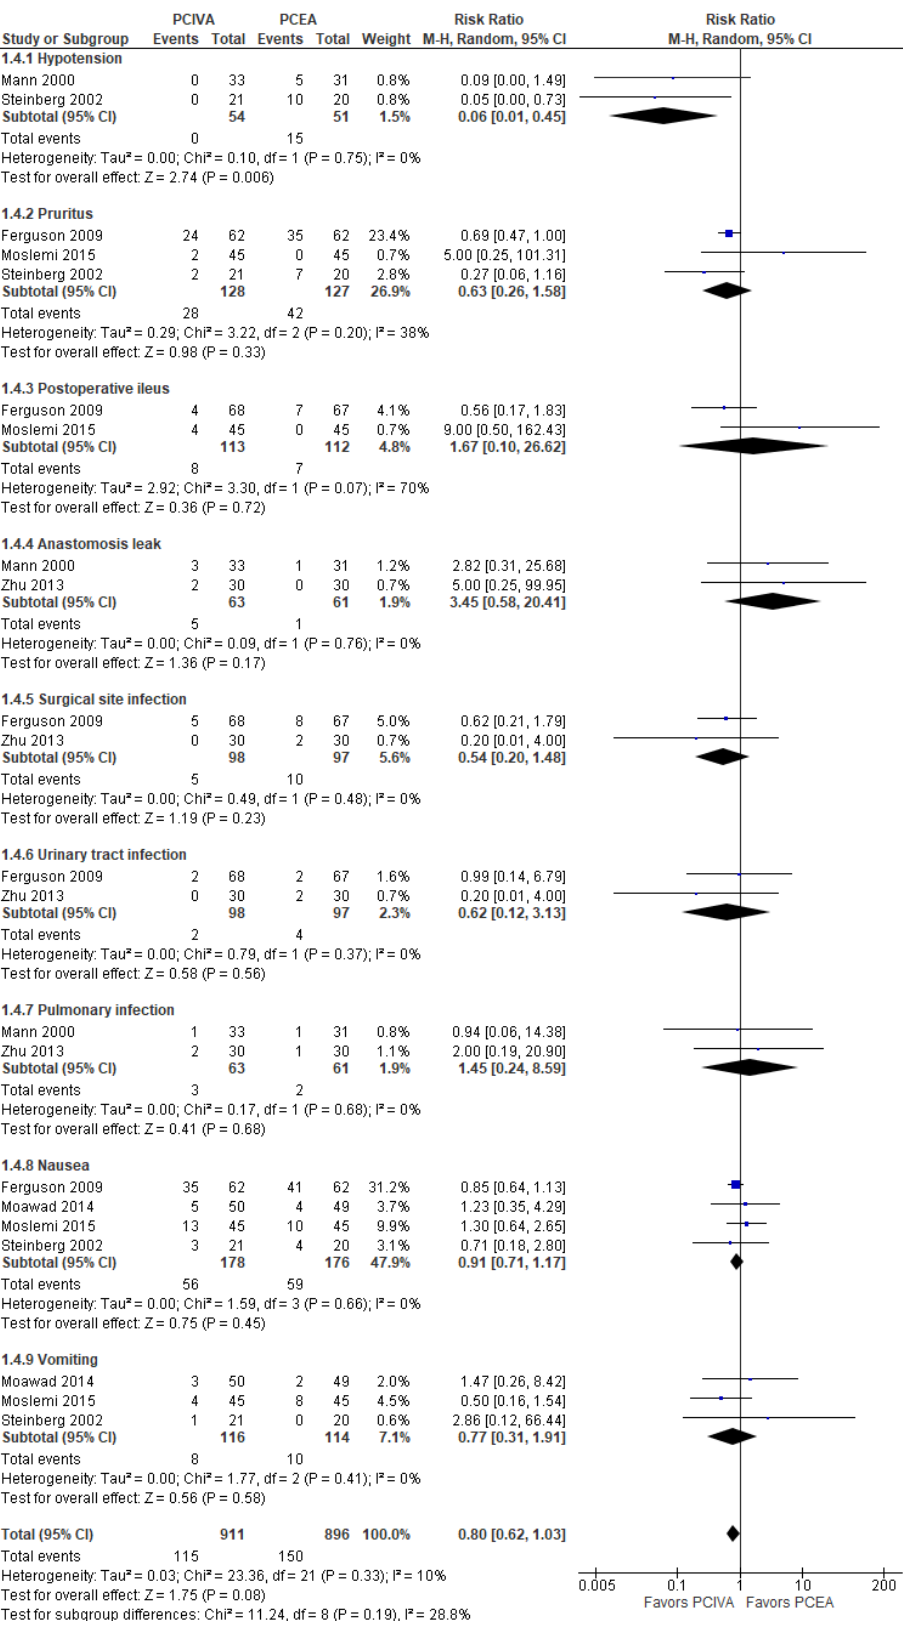
Figure 5. Postoperative complications. [10,17 – 19,21,22].